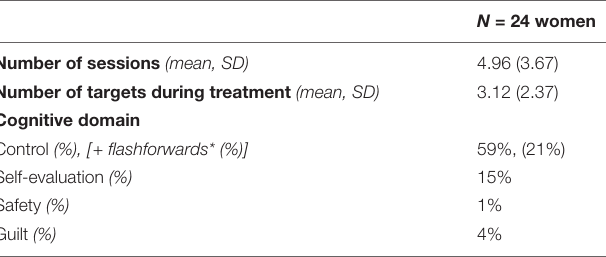
TABLE 2 | EMDR-therapy specific